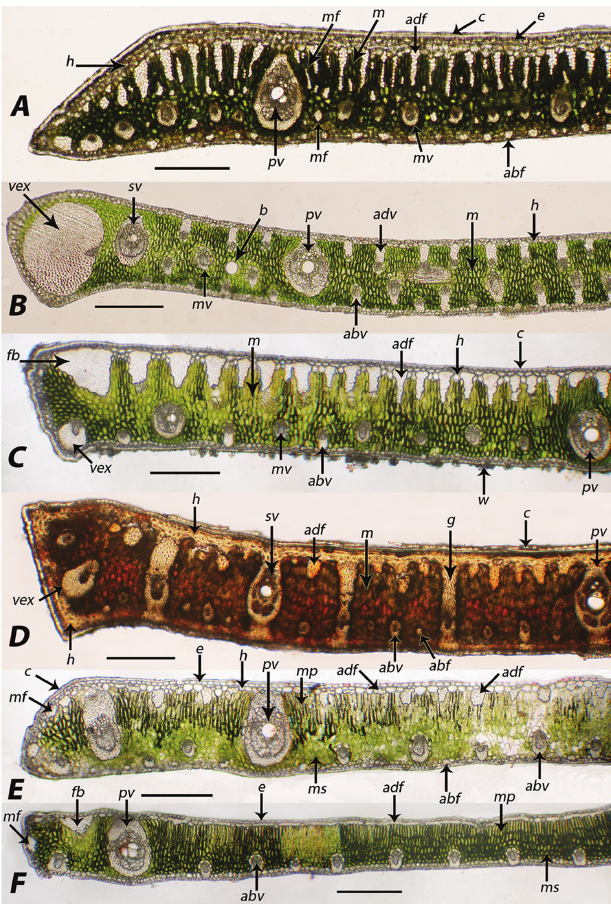
Figure 2. Characters. A Syagrus vagans with large adaxial fiber bundles reaching nearly ½ across the mesophyll, fiber bundles scattered throughout the mesophyll, mesophyll minor veins, abaxial fibers and a primary vein that is nearly connected to the hypodermis B S. lilliputiana showing a large marginal vein with an exaggerated fibrous sheath, adaxial minor veins, and an air bubble artifact C S. coronata with a large marginal fiber bundle, large adaxial fiber bundles, a small vein with an exaggerated fibrous sheath, and unattached primary vein D S. harleyi with a sclerenchymous hypodermis on the margin and along the adaxial surface, along with adaxial fiber bundles and abaxial minor vein symmetry (mirrored anatomy) and fibrous extensions from minor veins forming a girder E S. orinocensis with a mesophyll differentiated into palisade and spongy layers, marginal vein with fibrous sheath noticeably thickened adaxially, many fiber bundles along the adaxial surface, many of which are only one-cell thick and others reaching less than 1/5 across the mesophyll, also note very small abaxial fiber bundles often alternating with abaxial minor veins F S. vermicularis with an adaxial fiber bundle forming a continuous single layer of fiber cells in the hypodermis. abf = abaxial fiber bundle adf = adaxial fiber bundle abv = abaxial minor vein adv = adaxial minor vein b = trapped air bubble artifact c = cuticle e = epidermis fb = larger fiber bundle g = girder vein h = hypodermis hf = fibrous hypodermis m = mesophyll mf = marginal fiber bundle mp = palisade mesophyll ms = spongy mesophyll mv = mesophyll minor vein pv = primary vein sv = secondary vein vex = vein with exaggerated fibrous sheath w = wax. Bar scale = 0.25